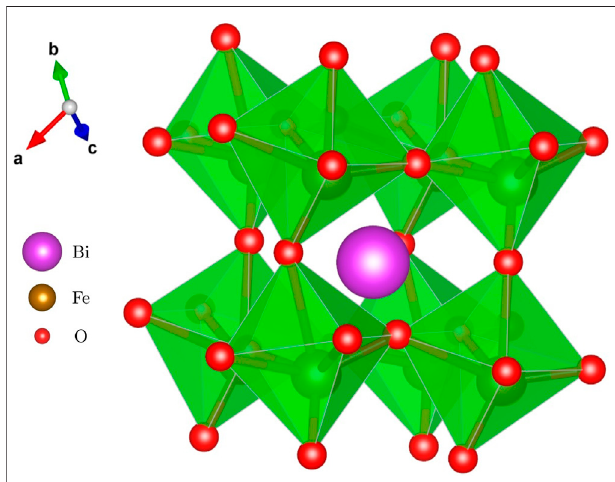
FIGURE 1 | Crystal structure of BiFeO 3 (space group R3c , No. 161) consistsofFe 3+ cationsoctahedrallycoordinatedbyoxygenions.Bi 3+ cations are excentrically located in the cavities formed by FeO 6